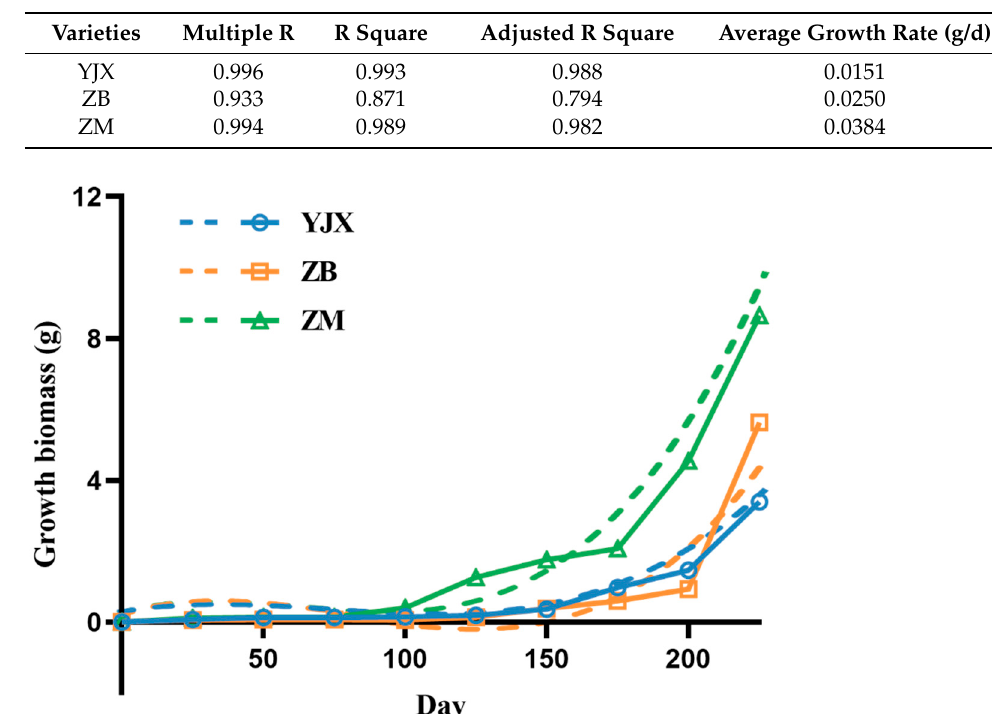
Table 1. Evaluating the accuracy of regression models.